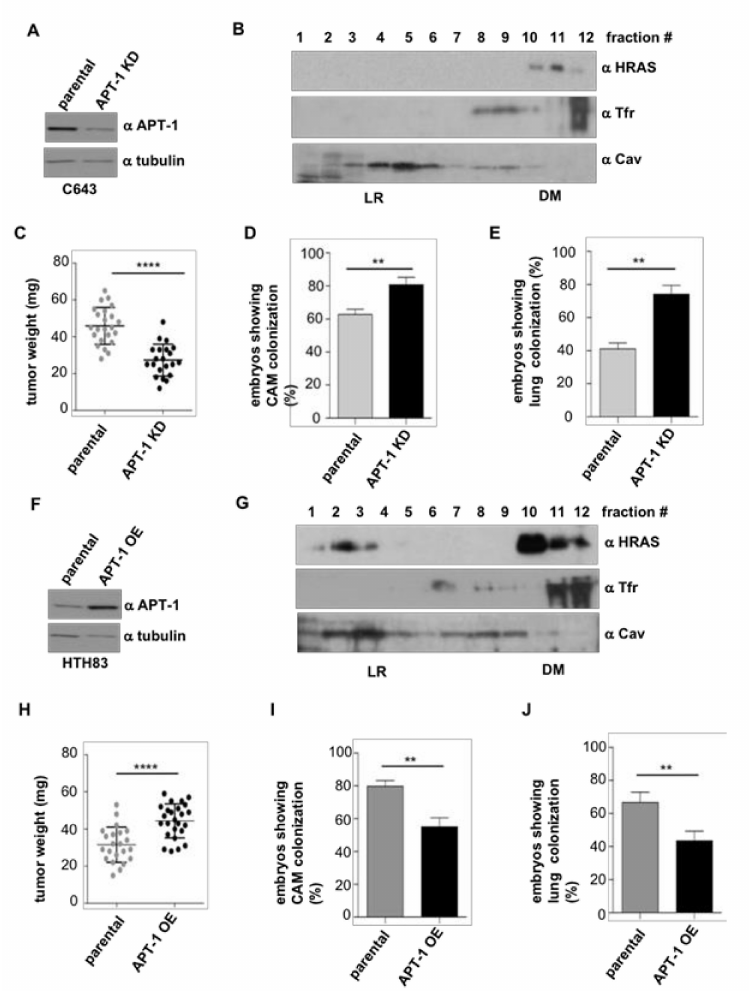
Figure 7. Alterations on APT-1 levels determine thyroid tumor behavior. ( A ) APT-1 levels in C643 cells after APT-1 shRNA-mediated knockdown (APT-1KD) compared to parental cells. ( B ) Endogenous HRAS localization at LR and DM fractions of C643 APT-1 KD cells. ( C ) Size of the tumors, ( D ) intravasation, and ( E ) distant metastases in APT-1 KD cells compared to the parental C643 line. ( F ) APT-1 levels in HTH83 cells after ectopic overexpression (APT-1OE), compared to parental cells. ( G ) Endogenous HRAS localization at LR and DM fractions of HTH83 APT-1 OE cells. ( H ) Size of the tumors; ( I ) Intravasation and ( J ) Distant metastases, in APT-1 OE cells compared to the parental HTH83 line. Data show mean ± SD ( C , H ); mean ± SEM ( D , E , I , J ) from three independent experiments using 6–12 embryos per case. ** p < 0.01 and **** p < 0.0001 by two-tailed unpaired Student t